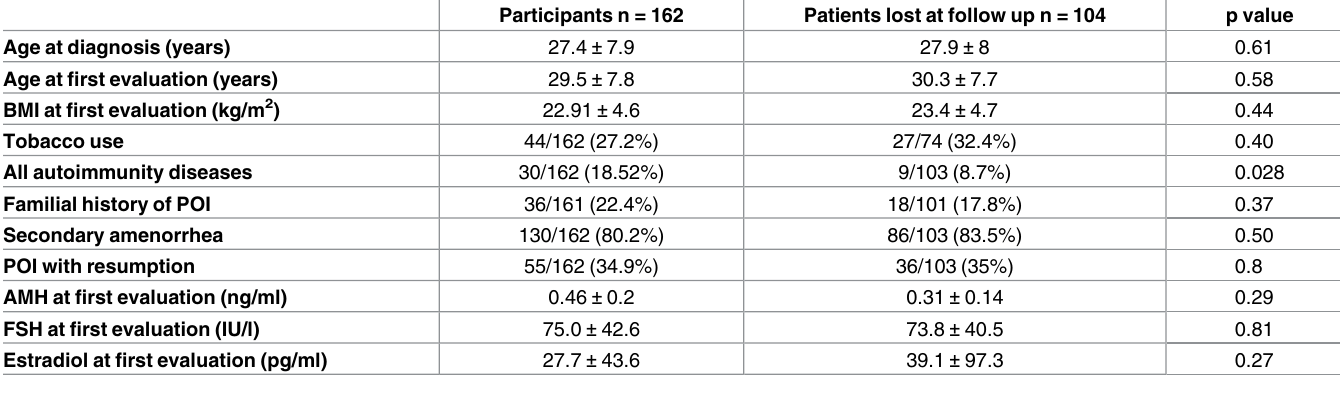
Table 1. Clinical and hormonal characteristics of the POI patients included (n = 162) or not (n = 104) in the